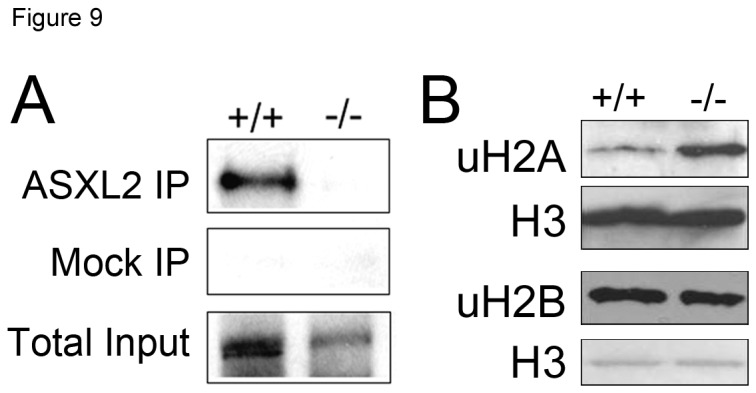
ASXL2 interacts with BAP1 in vivo and is required for efficient deubiquitination of uH2A.(A) Co-IP analysis of interaction between ASXL2 and BAP1. Wild-type and Asxl2
-/- heart extracts were IPed using KC17 anti-ASXL2 antibody. Mock IP was performed with pre-immune rabbit serum. IPed samples were run on SDS-PAGE and probed with an anti-BAP1 antibody (Millipore). (B) Western blot analysis of bulk uH2A and uH2B in wild-type and Asxl2
-/- hearts. To control for comparable protein loading, the blot was stripped and re-blotted for histone H3. The results shown are representative of three sets of experiments, each using a pair of wild-type and Asxl2
-/- hearts.